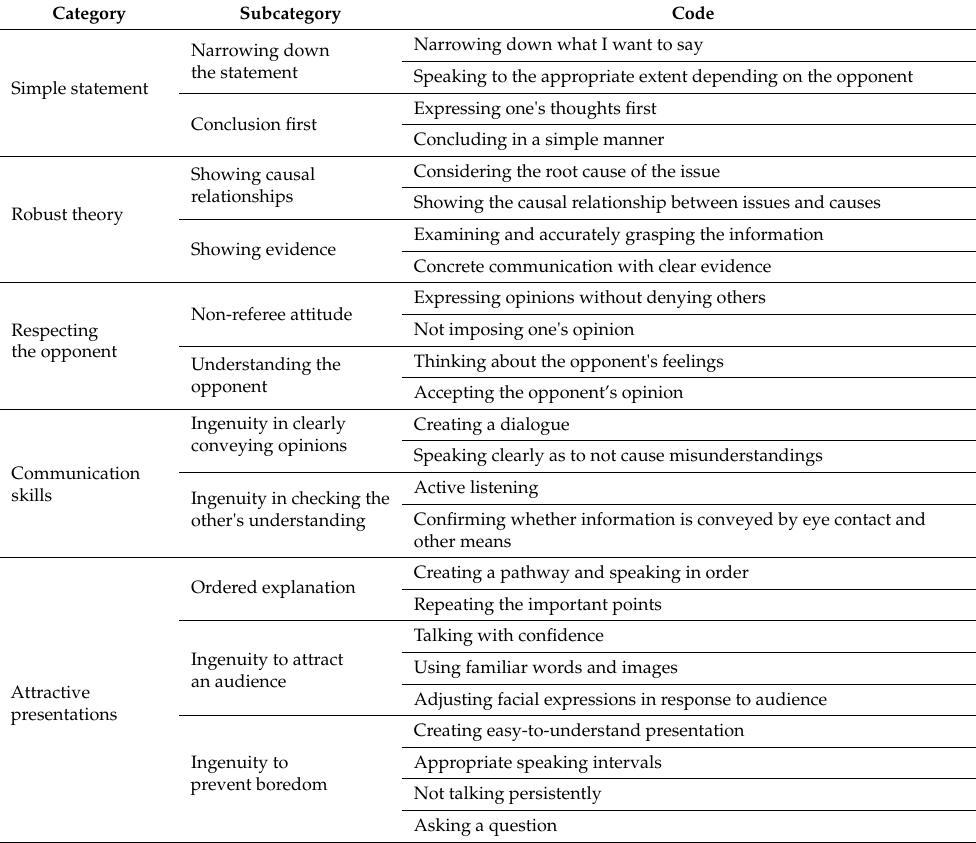
Table 2. Content categorization of Task 2 responses to “What do you need to do in order to clearly convey your thoughts and opinions to others?”.